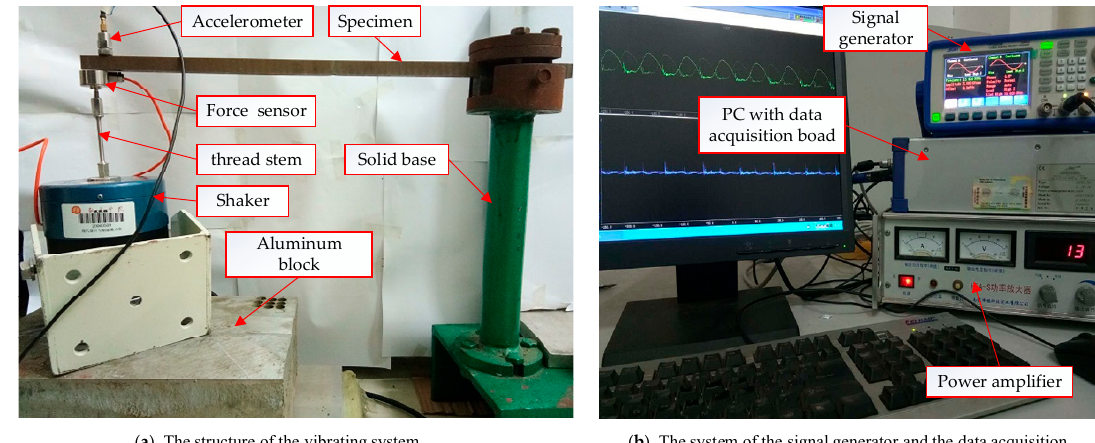
Figure 6. Fatigue crack growth setup: ( a ) single edge notched beam specimen, ( b ) three-point bending test, ( c ) rack length measured by optical microscope.